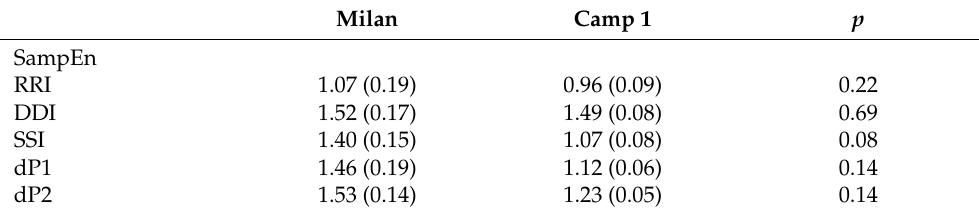
Table A2. Entropy indexes for embedding dimension m = 2 in N = 5 climbers sleeping in Milan (sea Table A1. Entropy indexes for embedding dimension m = 2 in N = 21 participants sleeping at high level) and Everest Camp 1 (6000 m a.s.l.) by type of altitude: median (SE median) by type of tachogram.